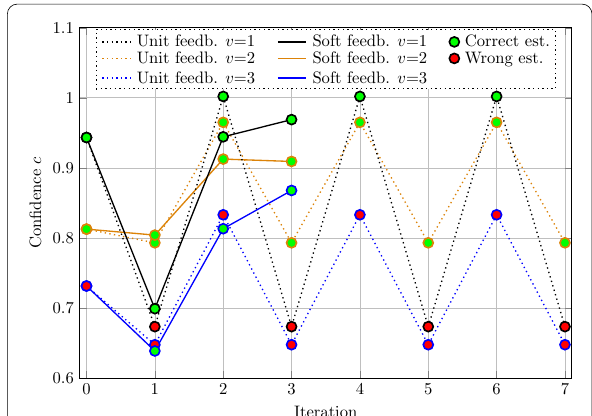
Fig. 6 Confidence ˆ c during iterative decoding of V = 3 vectors using either unit-feedback or soft-feedback. The correct estimations are marked in green and the incorrect in red